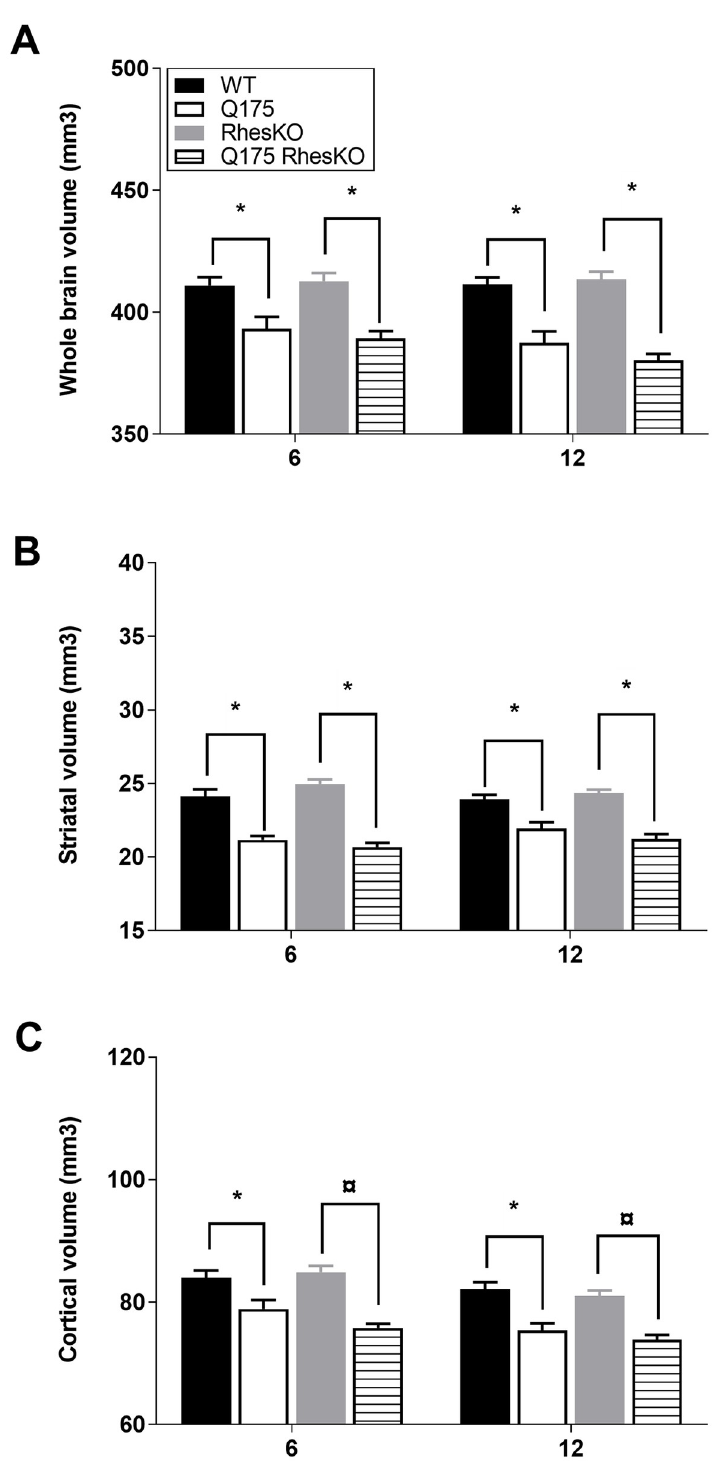
Fig 4. MRI analysis of Q175/Rhes female mice at 6–12 months of age. (A) whole brain volume, (B) striatal volume and (C) cortical volume. Data are presented as mean, + SEM (WT n = 9; RhesKO n = 11; Q175 n = 9; Q175;RhesKO n = 9); Two-way mixed ANODE followed by Tukey’s test, � p < 0.05, Q175 vs. WT andQ175;RhesKO vs. RhesKO.